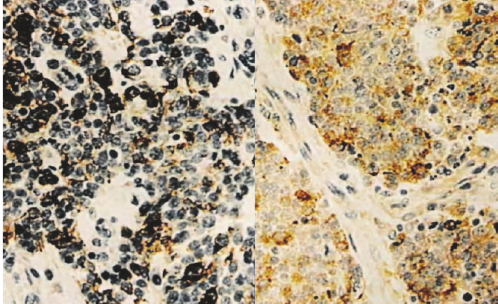
Figure 2: Neuroendocrine carcinoma of the breast (HES; × 100): tumoral diffuse proliferation due to medium and large cells invading the gland and oppressing lobules and ducts (collection of the Pathological Anatomy Laboratory, the University Teaching Hospital of Lom´e).